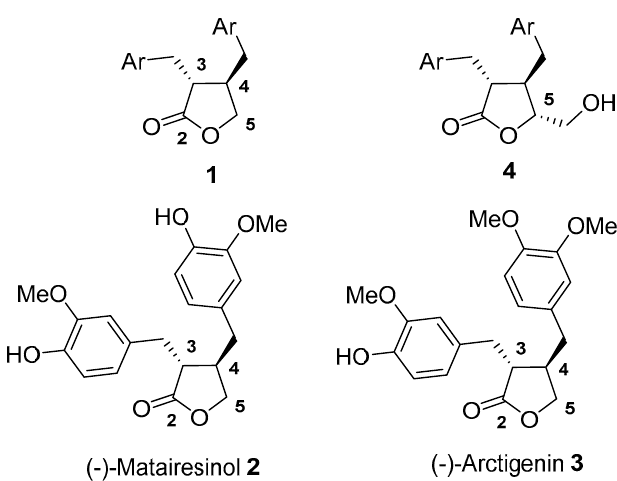
Figure 1. General structures of butyrolactone lignan 1 , natural dibenzylbutyrolactone lignans, ( − )-matairesinol 2 and ( − )-artigenin 3 , and 5-hydroxymethyl analogues 4 .